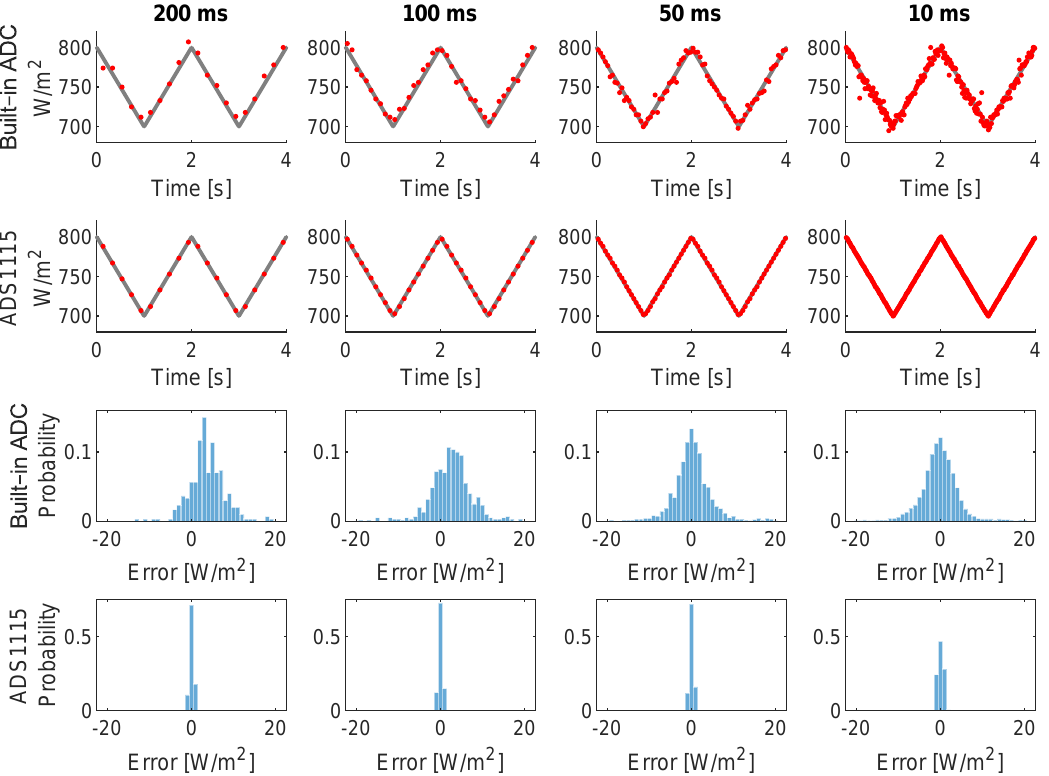
Figure 1. Comparison between ESP32 embed ADC and the external ADC